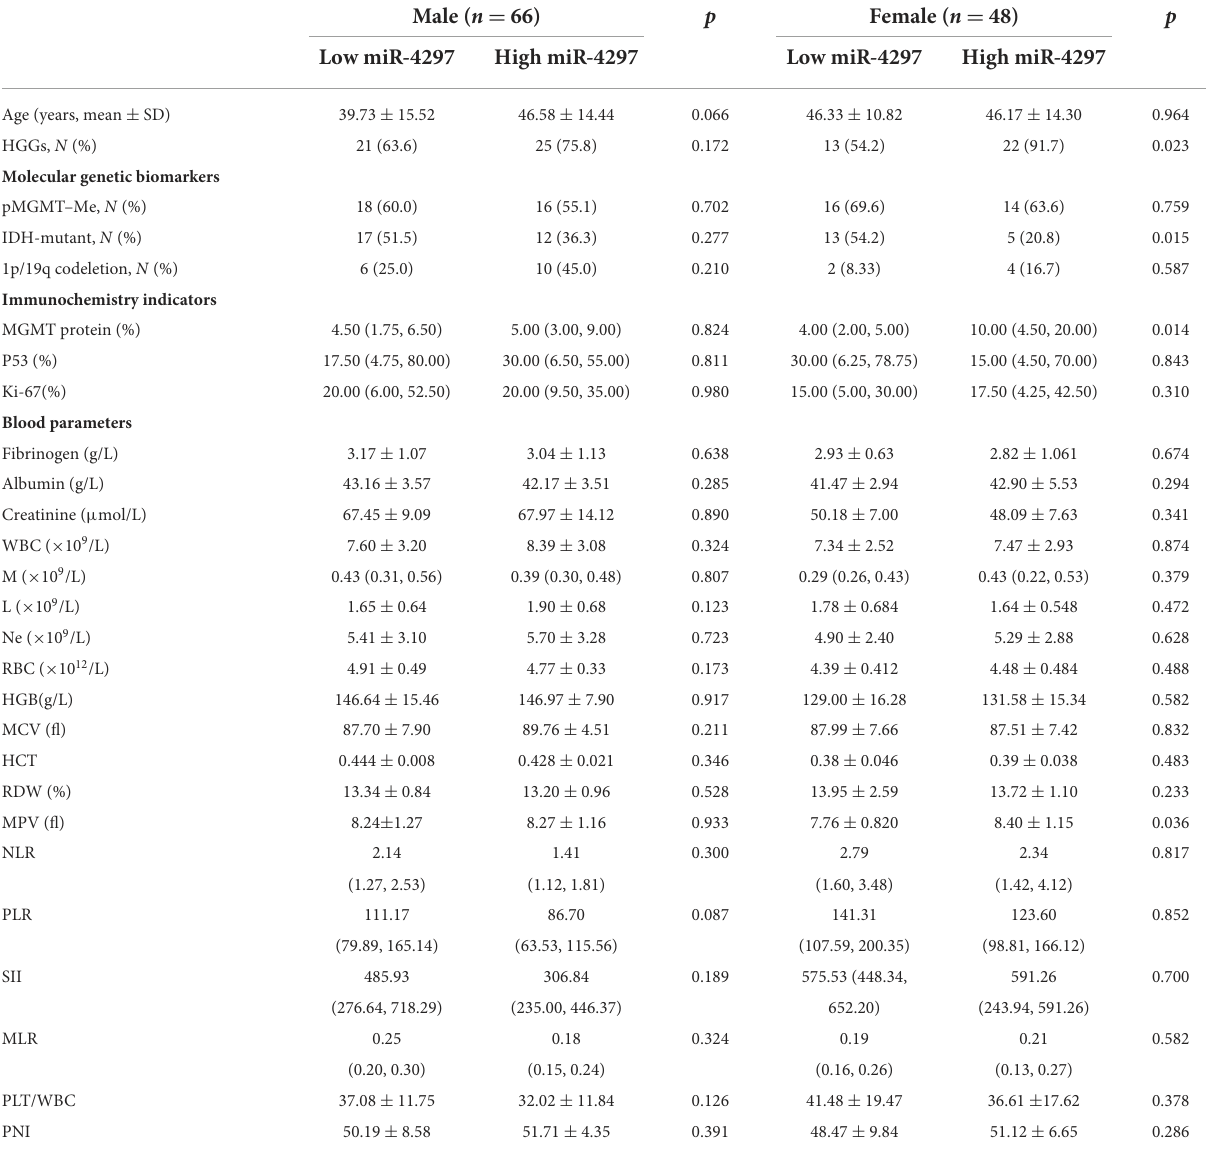
TABLE 2 Clinical parameters in miR-4297 low and high expression group by